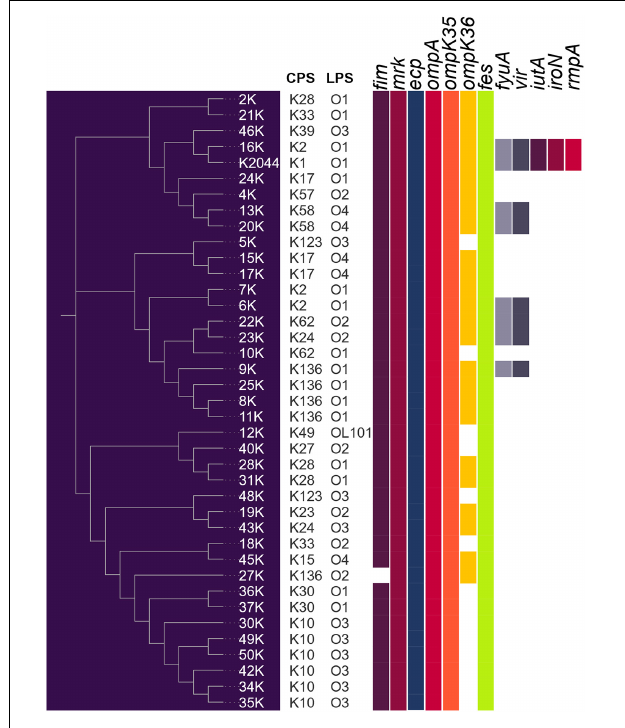
FIGURE 2 | Virulome of K. pneumoniae strains. Color filled box mean presence of virulence factor. NTUH-K2044 was added as reference strain.